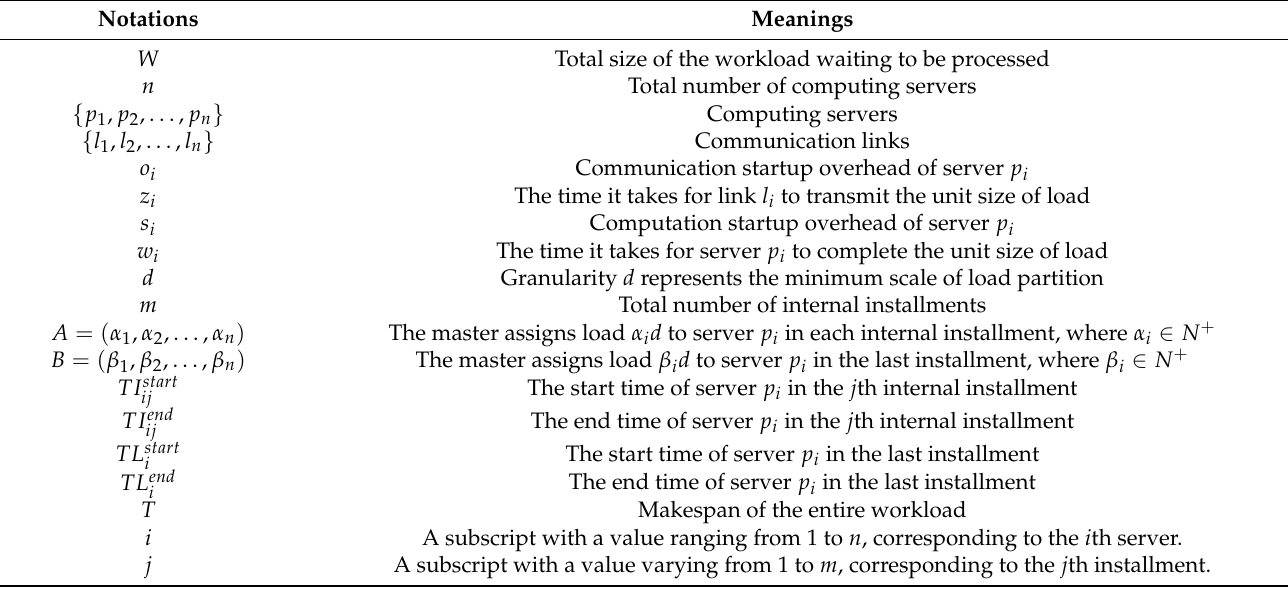
Table 1. Notations and their meanings.